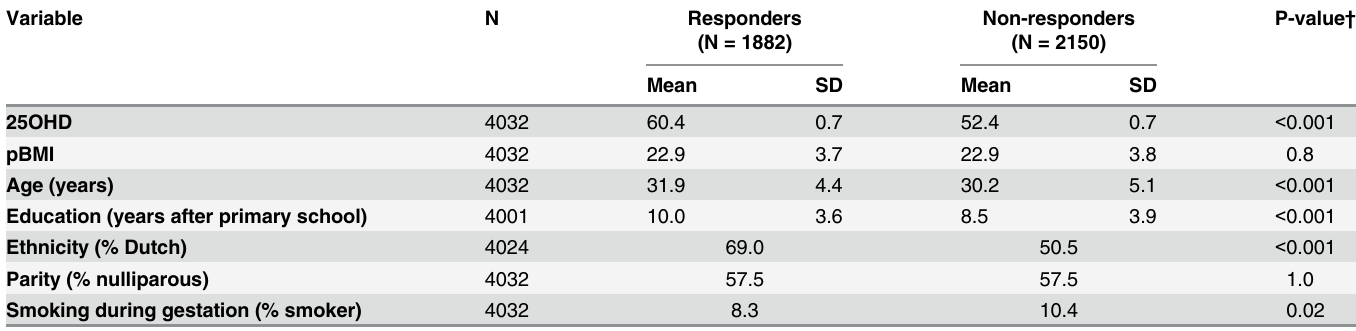
Table 1. Comparison of eligible mothers whose children were suitable for follow-up who either completed (responders) or did not complete fol- low-up (non-responders).